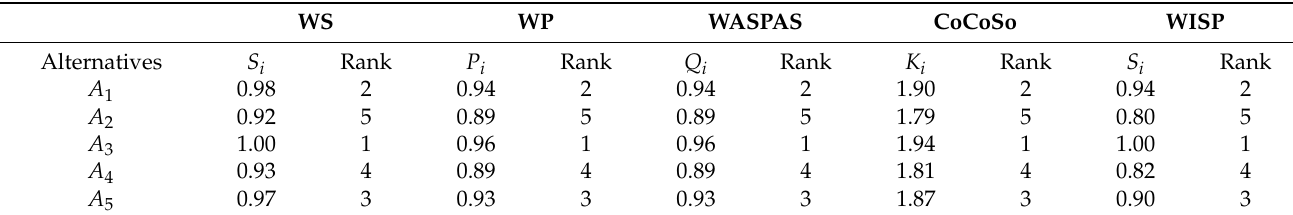
Table 15. Ranking of alternatives on the basis of 50 virtual respondents and the proposed grey approach.